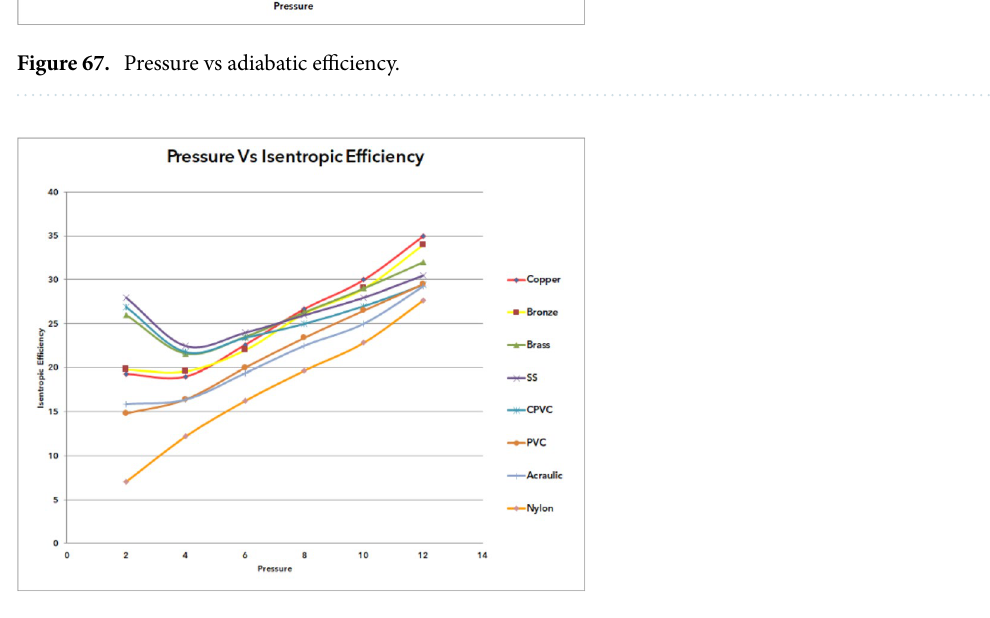
Figure 68. Pressure vs isentropic